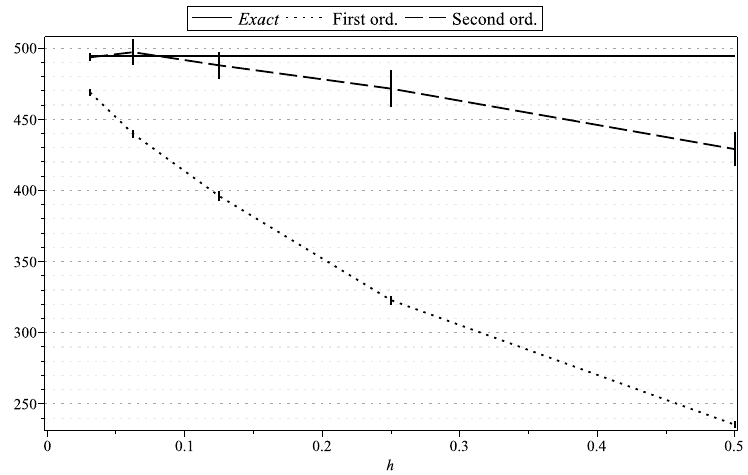
) 4 as functions of h : σ = 1.5, x 1